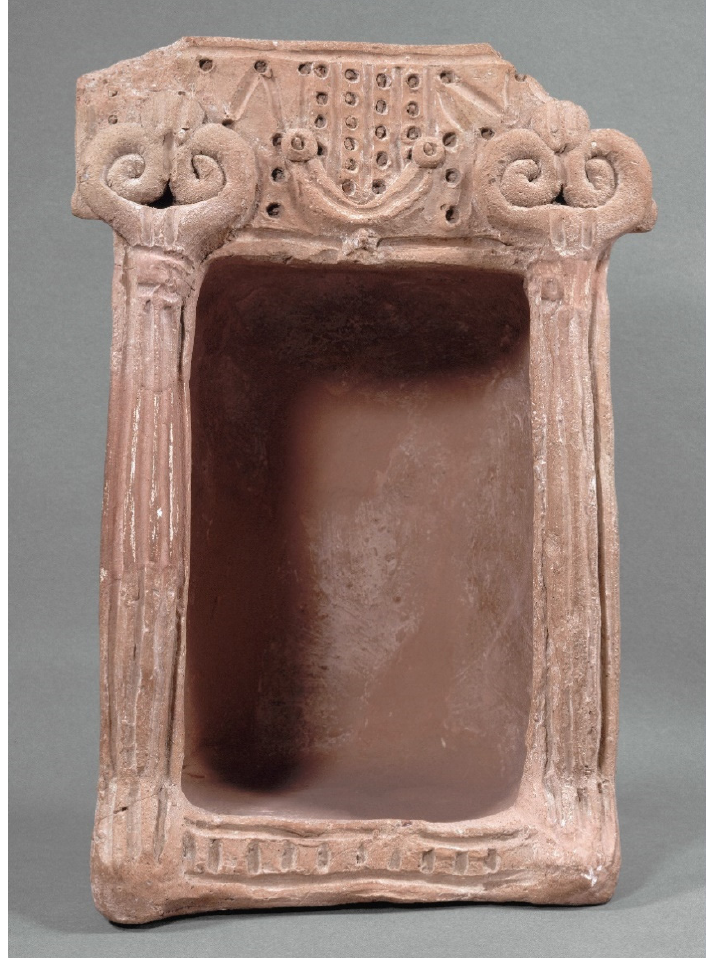
Figure 11. The portable shrine from Pit 241 in Building 149 at Tell el-Far‘ah North (© RMN—Grand Palais, Musée du Louvre, les frères Chuzeville).